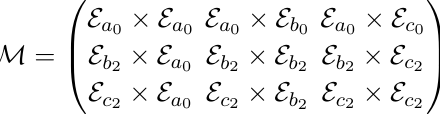
b (cid:12) c (cid:11) 2 0 2